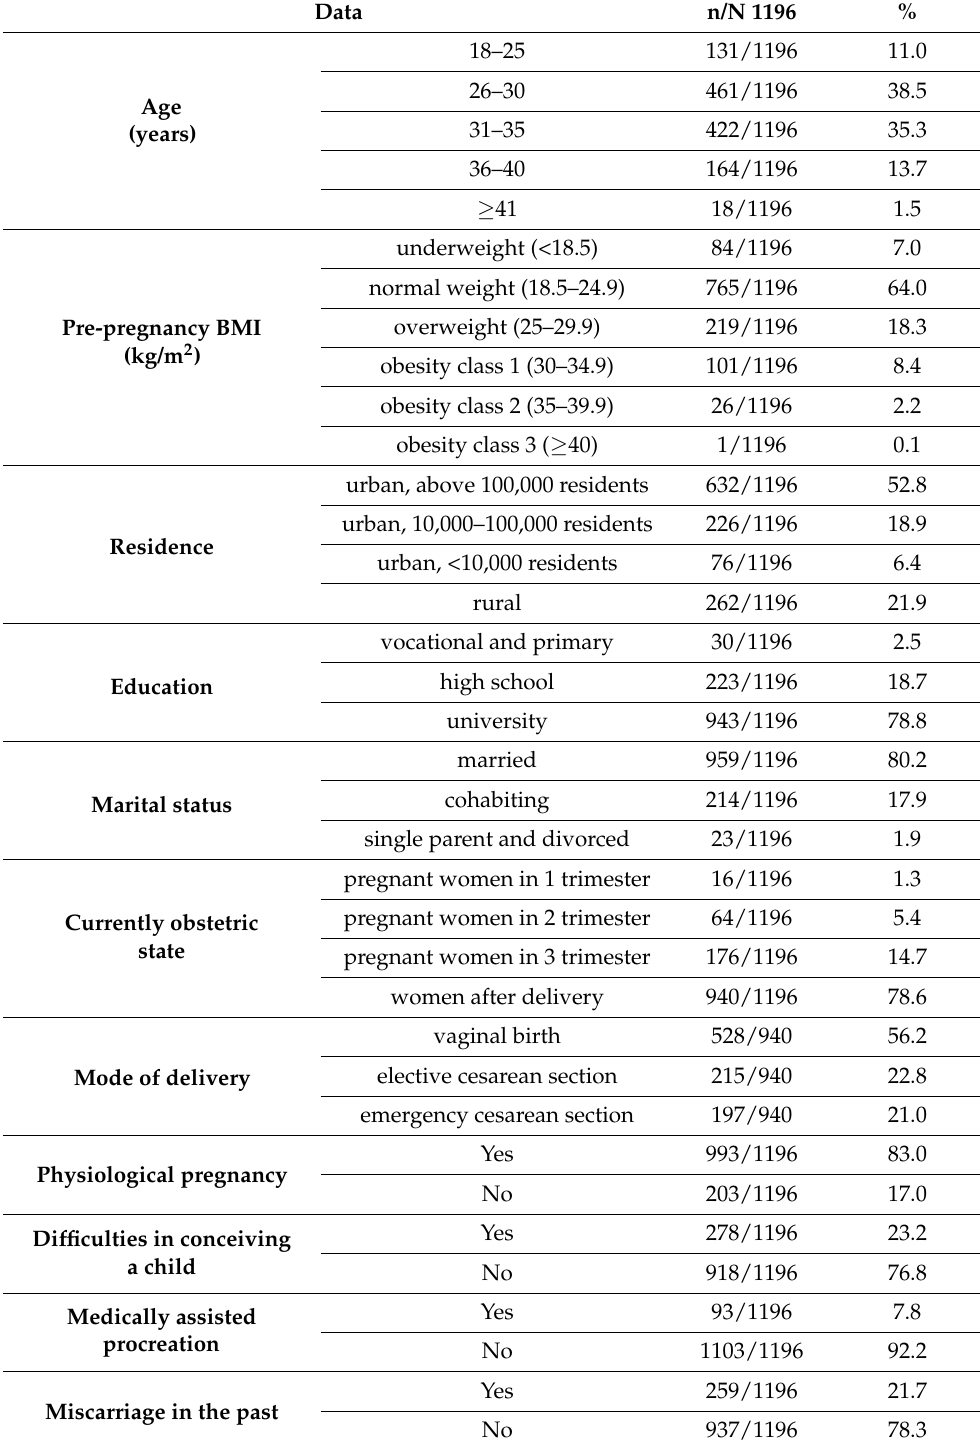
Table 1. Participants’